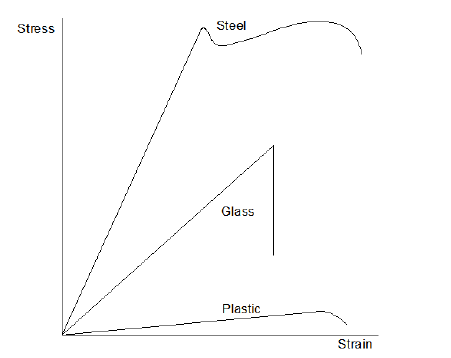
Figure 1. Stress-strain diagram for steel, glass and plastic